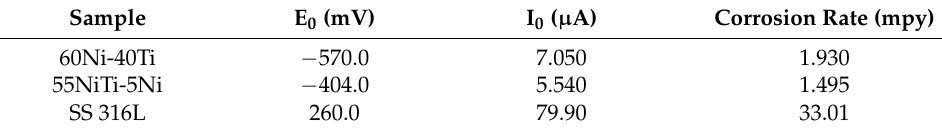
Figure 11. Potentiodynamic polarization curves of coatings and substrate. Table 5. Tafel fitting parameters of coatings and the